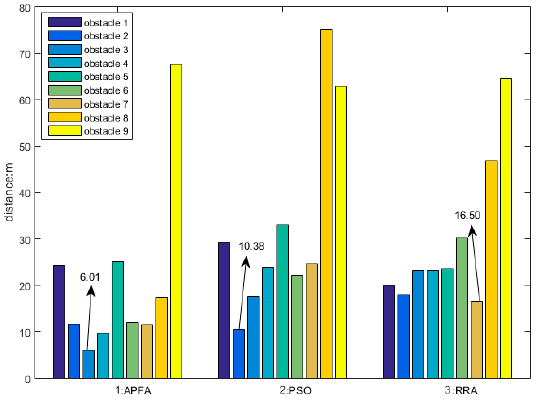
Figure 13. Smallest distance between AUV and obstacles.